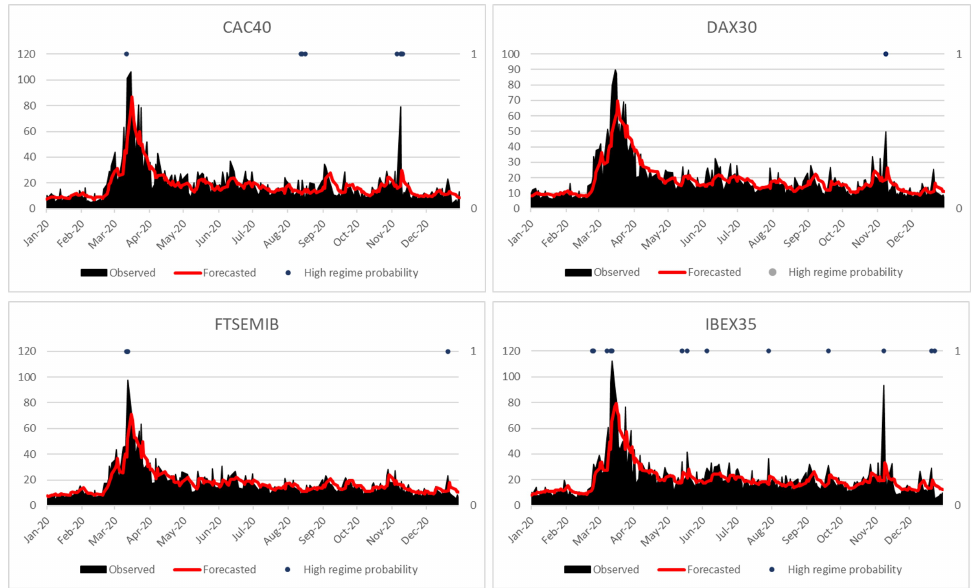
Figure 5. CAC40, DAX30, FTSEMIB and IBEX35 realized (black line), forecasted (red line) volatil- ity and high regime forecasted probability. Estimation period: 1 June 2009 to 31 December